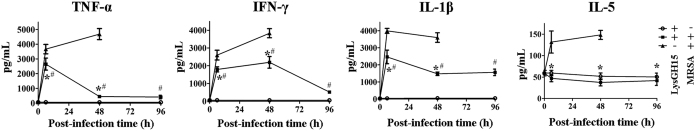
LysGH15 reduced pro-inflammatory cytokines.The BALB/c mice immunized with LysGH15 were injected intravenously with MRSA strain YB57 (1 × 1010 CFU/mouse). One hour later, these mice were treated with LysGH15 or the control buffer. At the indicated time points, the levels of TNF-α, IFN-γ, IL-1β, and IL-5 in the serum were determined (n = 6 mice per group per experiment). *P < 0.05 compared with the buffer-treated control; #P < 0.05 compared with the uninfected control. The data are representative of 3 experiments.